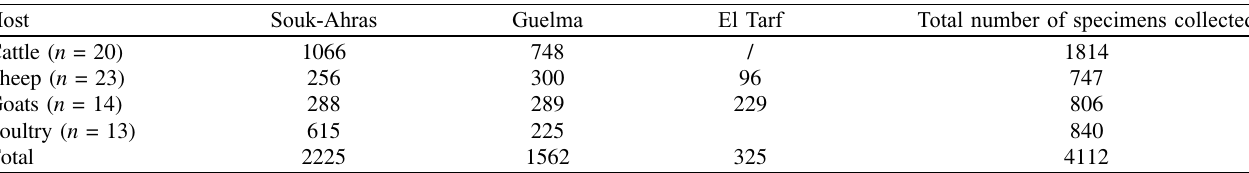
Table 1. Sampling regions, number of parasitized animals, and specimens of lice collected from sheep, cattle, goats, and poultry in Algeria. Souk-Ahras Guelma El Tarf Total number of specimens collected